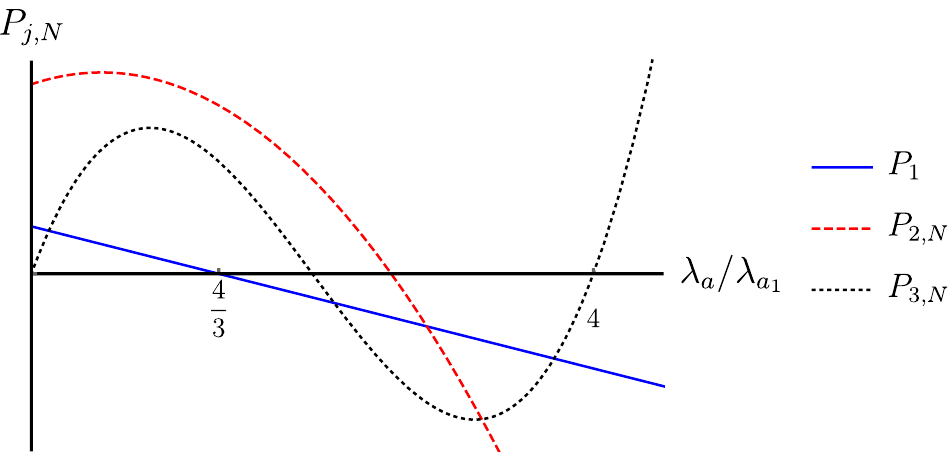
Figure 4 . Schematic plot of the polynomials P j;N appearing in the equal-mass sum rules. For each curve there is some a (cid:3) such that g a nonlinear curves with the horizontal axis near the middle of the plot depend on the dimension N of the internal manifold and tend to 4 = 3 as N